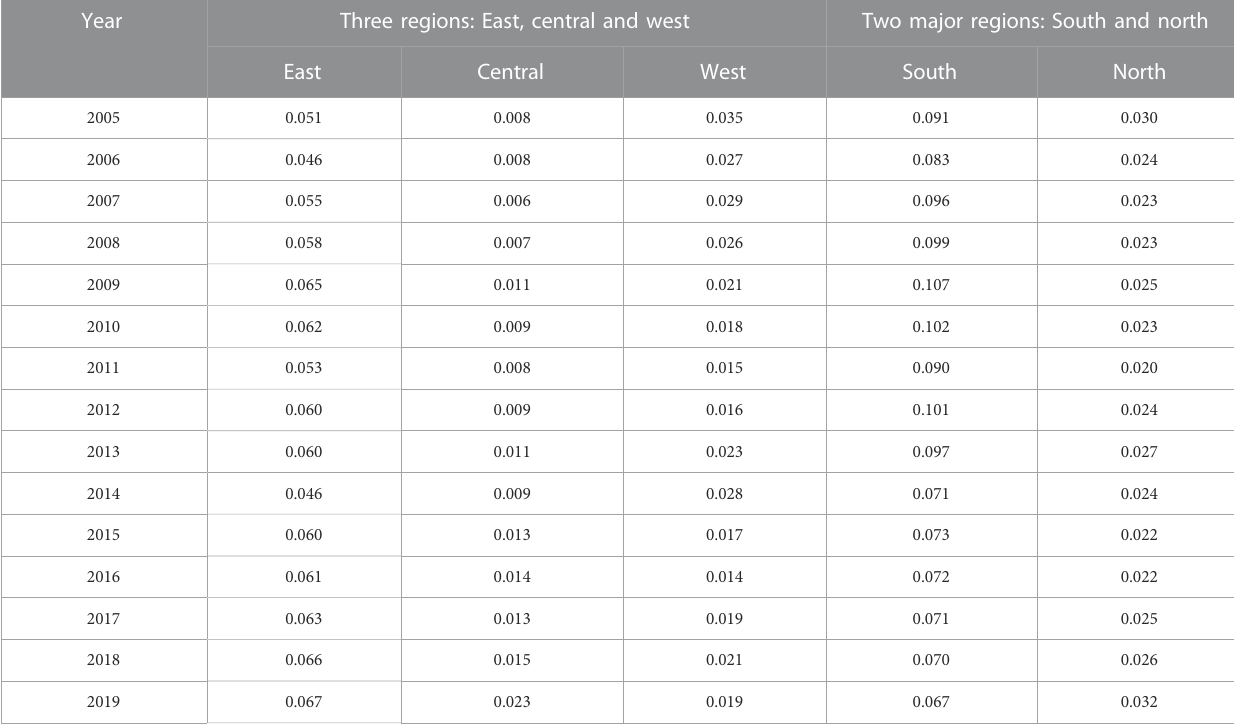
TABLE 3 Inter-provincial differences in economic resilience of Chinese cities. Year Three regions: East, central and west Two major regions: South and